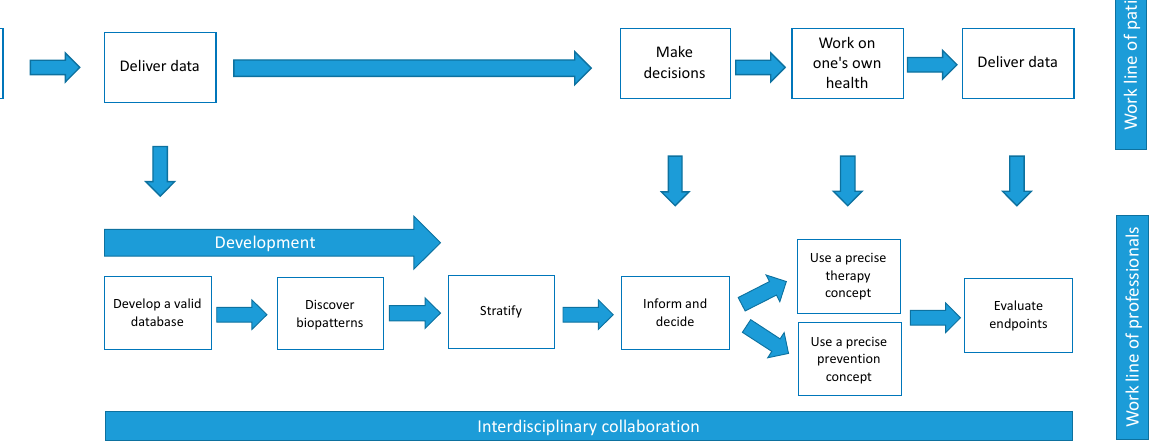
Figure 2. Patients’ and professionals’ work in PM.